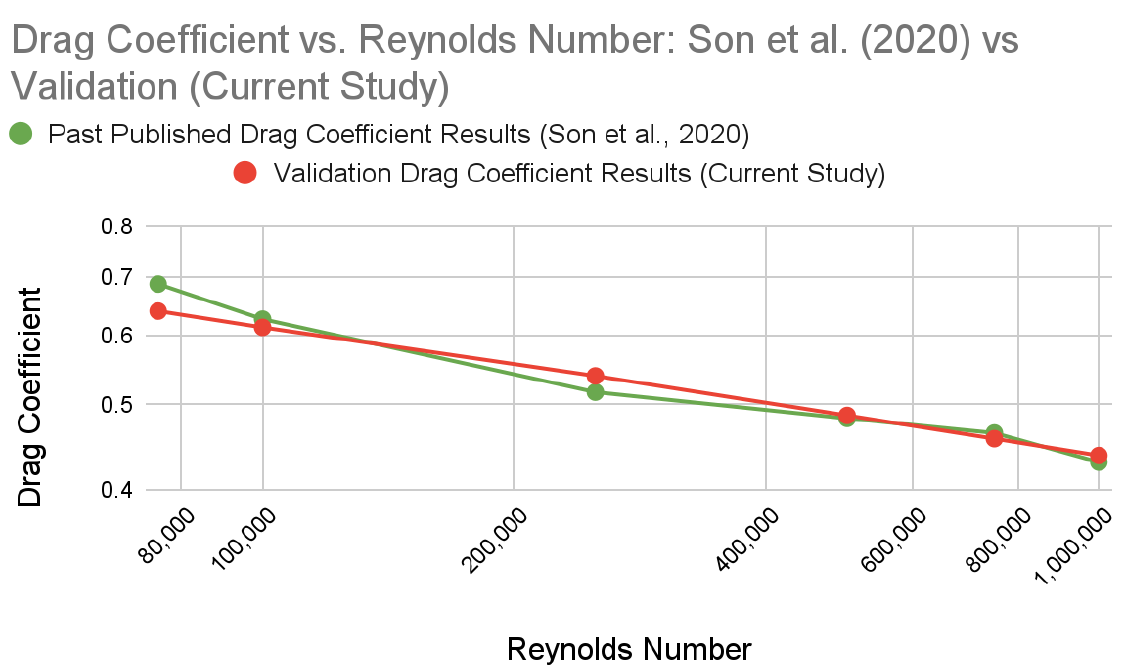
Figure 7. Graph Comparing Drag Coefficient Results: Son et al. [9] vs. Validation.